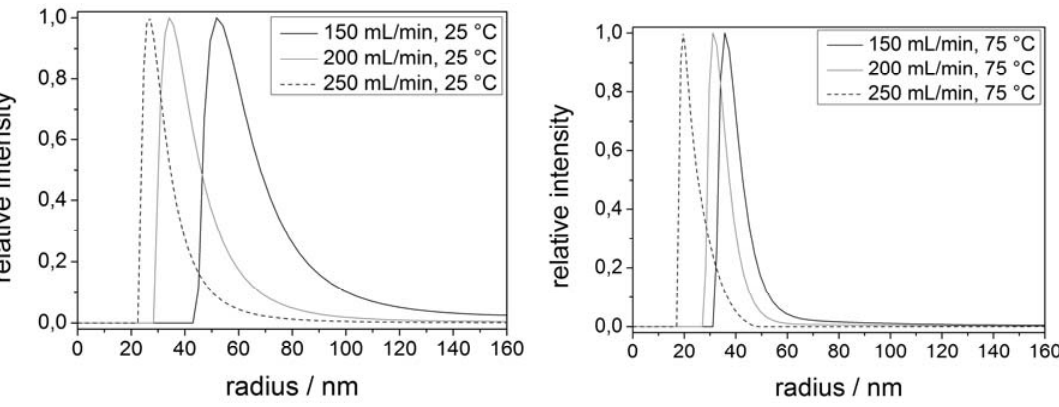
Figure 9. Particle size of the synthesized magnetite determined by dynamic light scattering.